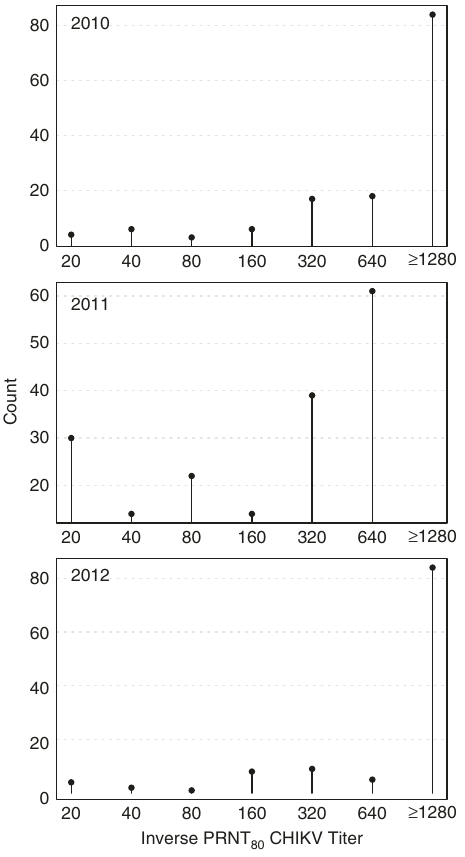
Fig. 4 Inverse plaque reduction neutralization tests (PRNT 80 ) CHIKV titers by year. Figure shows number of animals (counts) per antibody titer by year for all three species of